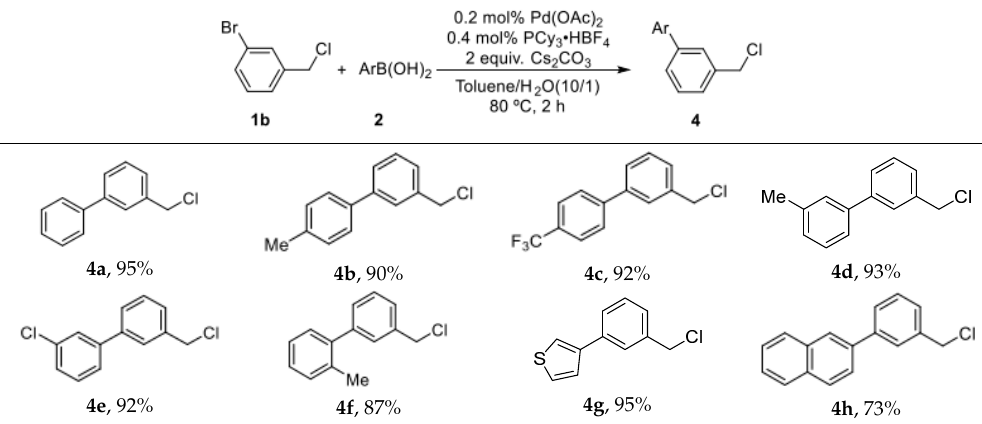
4e , 92% 4f , 87% 4g , 95% 4h , 73% a Reaction conditions: 1-bromo-3-(chloromethyl)benzene 0.30 mmol, arylboronic acid 0.33 mmol, 0.2 mol % Pd(OAc)